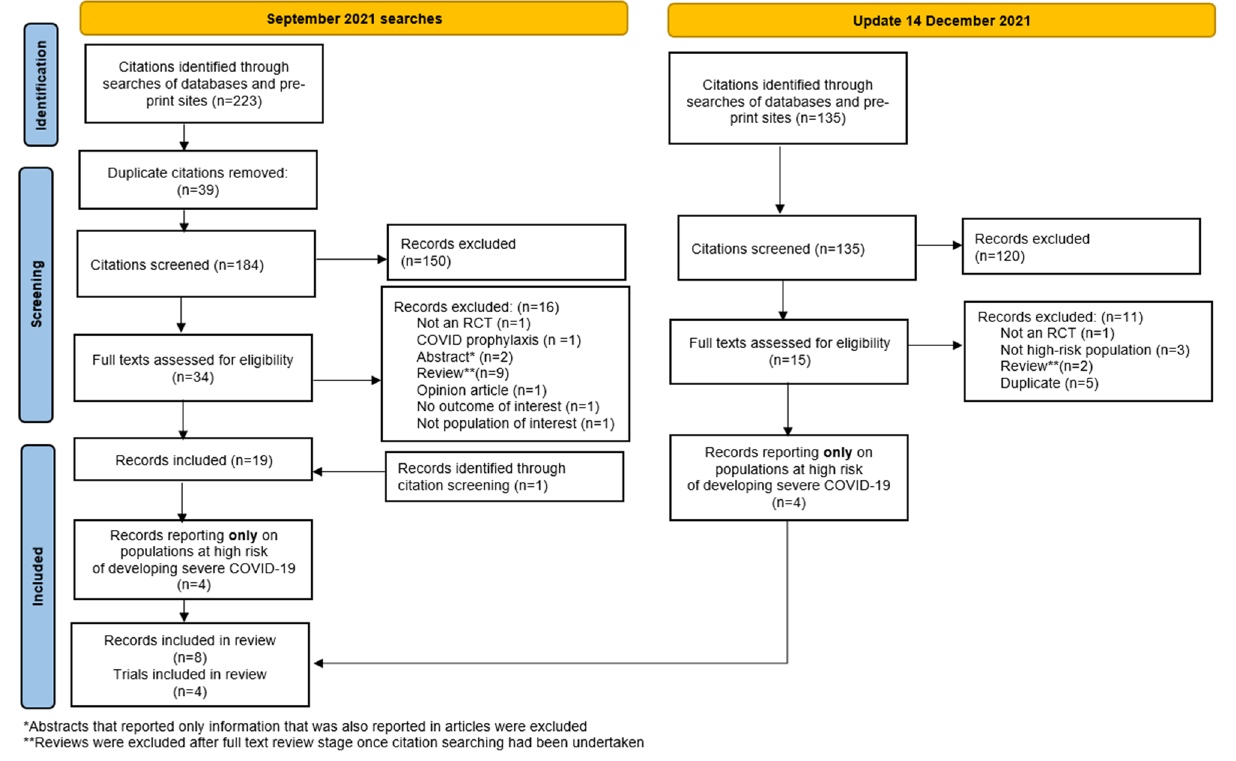
Figure 1. PRISMA flow